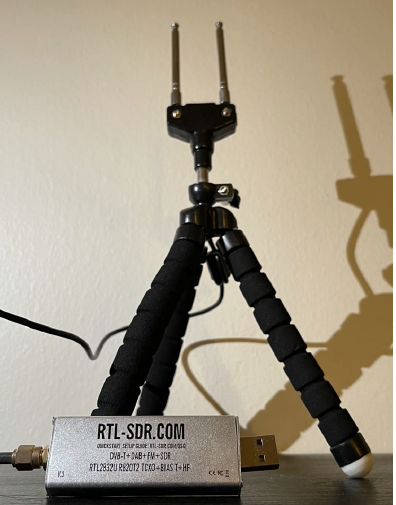
Figure 1. SDR RTL2832U and antenna used in PRF data